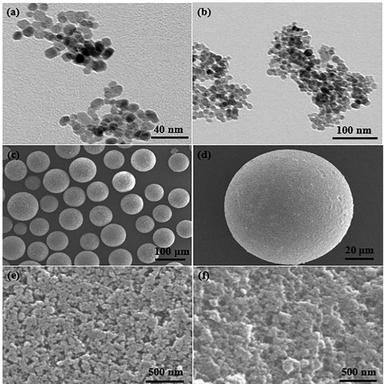
(a) TEM images of Fe3O4 and (b) OA-MNPs; (c) low-magnification and (d) high-magnification SEM images of NDAM-40; (e) surface and (f) internal topography of NDAM-40.